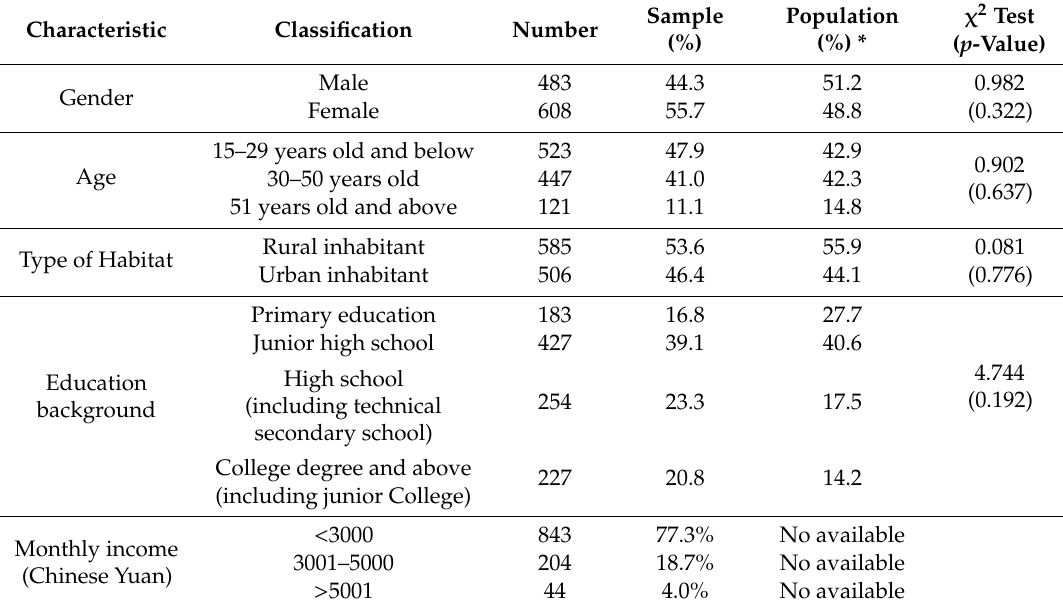
Table 2. Descriptive statistics of the sample